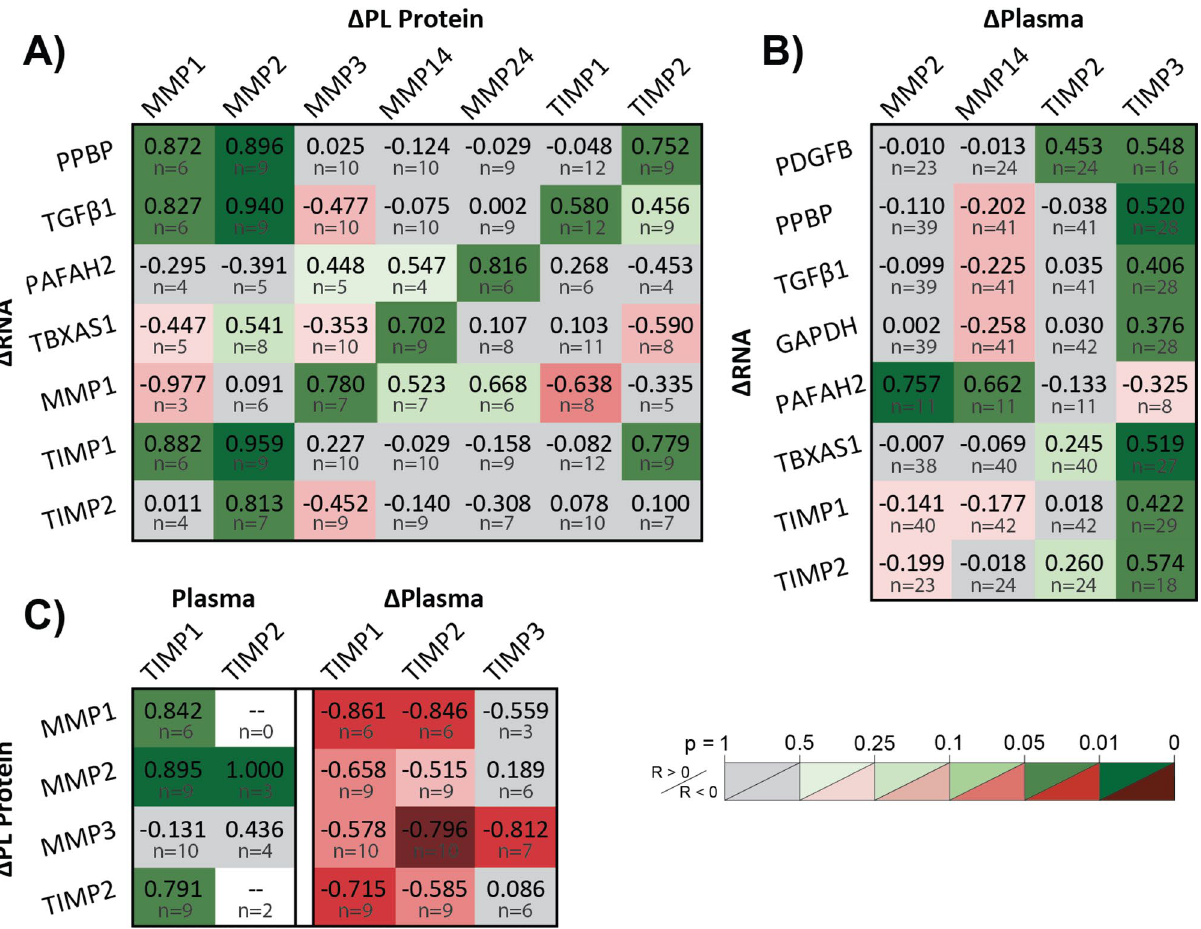
Figure 6. Pro-fibrotic platelet secretomes correlate to elevated plasma MMPs and TIMPs. Pearson correlation coefficients, R, of fibrotic platelet ( A ) ΔRNA against platelet ΔMMPs and ΔTIMPs, ( B ) ΔRNA against plasma ΔMMPs and ΔTIMPs, and ( C ) Δprotein against plasma TIMPs and ΔTIMPs. ( A ) Platelets with acutely enhanced MMP and TIMP secretomes have amplified transcripts for MMPs, TIMPs, platelet activators, and other fibrotic factors. ( B ) Patients presenting acute plasma MMP and TIMP increases have platelets exhibiting greater RNA for fibrotic factors. ( C ) Chronic plasma TIMP elevation accompanies greater platelet production of MMPs and TIMPs, and increased intra-dialysis MMP and TIMP secretion. Figure was prepared in Microsoft Excel v2020 (Microsoft Corp. www. micro soft. TIMP elevation (R 2 = 0.79, p = 0.043) and decreases in platelet lysate MMP/TIMP with acute plasma TIMP eleva- tion (R 2 = 0.79, p = 0.043) (Table ST13). Higher plasma levels of fibro‑protective GFs correlate to lower fibrotic and higher regenerative contributions by platelets. Higher plasma levels of regenerative growth factors indicated platelets with decreasing fibrotic con- tributions (Fig. 7A). Plasma FGF2 correlated to reduced RNA for inflammatory IL1β and fibrotic TGFβ1.Platelet production and secretion of fibrotic CTGF and TIMP1 decreased with plasma FGF2 and IGF1, indicated by negative correlations to pre-HD levels and positive correlations to intra-HD changes. Using MLR, TGFβ1 RNA retention and reduced PL CTGF and TIMP1 predicted plasma FGF2 levels (R 2 = 1.0, p = 0.0021) (Table ST14). Further, platelet TIMP1 was predicted by plasma IGF1 depression pre-HD, accumulation intra-HD, and FGF2 clearance (R 2 = 1.0, p = 0.036) (Table ST14). However, unlike FGF2, plasma IGF1 correlated to increased platelet MMP1 RNA. Finally, clotting factor translation was reduced with ΔEGF, shown by TX RNA preservation. Acute elevation in fibrotic activity and PDGFs accompany a regenerative platelet response between treatment ses‑ sions. Acute enhancements in platelet secretome growth factors to acute plasma increases in fibrotic activ- ity suggest short-term behavioral adaptations between HD sessions (Fig. 7B). Increased fibro-protective RNA (FGF2 and EGF) with fibrotic plasma (MMP9, ΔPPBP, and ΔTIMP3) shows a regenerative shift post-HD. This is supported by platelet IGF1 and PDGF retention with plasma ΔMMPs and ΔTIMPs. FGF2 upregulation with ΔPDGFD and retention with pre-HD PDGFD demonstrate a case of fibrotic enhancement of regenerative potential. In fact, multivariate linear regression revealed that plasma MMP9, PDGFD, and PPBP positively pre- dict FGF2 upregulation (R 2 = 0.76, p = 0.015) (Table ST15). Further feedback activity is observed by secretome